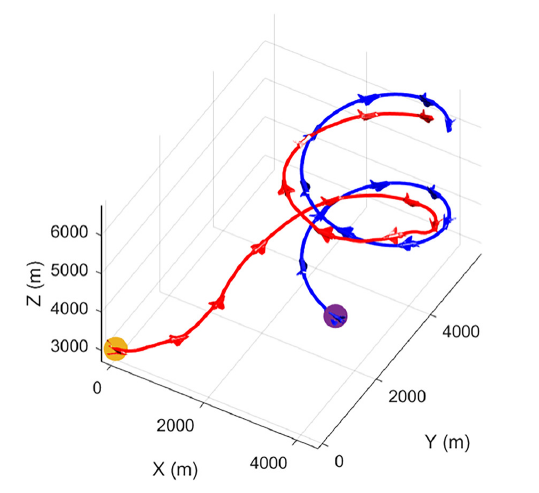
Figure 14. The two UCAV tracks in the middle training period in case 2.